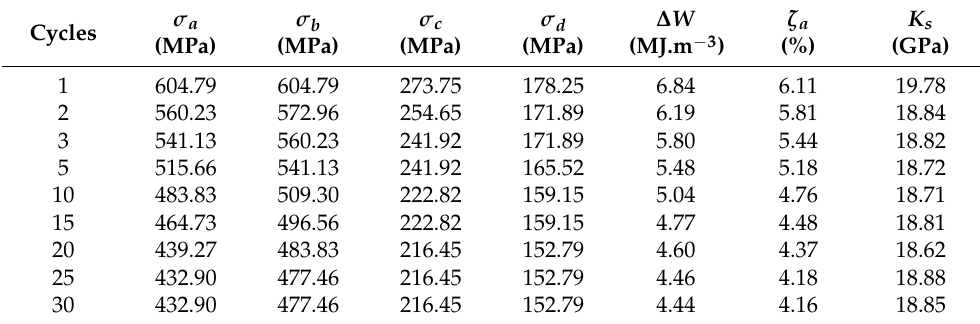
The effect of strain amplitude on the mechanical properties of superelasticity. A stress–strain curve with a diameter of 1.0 mm, a loading rate of 10 mm/min, and a strain amplitude of 3% is shown in Figure 3, and the parameters are shown in Table 2. As the strain amplitude of SMA wire increases, the cumulative residual deformation gradually increases. When the strain amplitude is small, the austenitic SMA wire is basically in the elastic stage, and the elastic modulus is approximately 450 MPa after stabilization. When the strain amplitude exceeds 1%, the SMA wire will un- dergo martensitic transformation and austenite transformation, showing super-elastic performance, and the greater the strain amplitude, the better its super-elastic perfor- mance, and the greater the energy dissipation capacity. The strain amplitude is the most significant factor affecting the energy dissipation capacity of SMA wires. When the strain amplitude increases from 3% to 8%, the single-turn energy consumption of the SMA wire increases from 4.46 MJ · m − 3 to 20.76 MJ · m − 3 , which increases the energy consumption by 3.65 times. As the strain amplitude increases, the damping ratio gradually increases, the equivalent secant stiffness gradually decreases, and the energy consumption capacity continues to